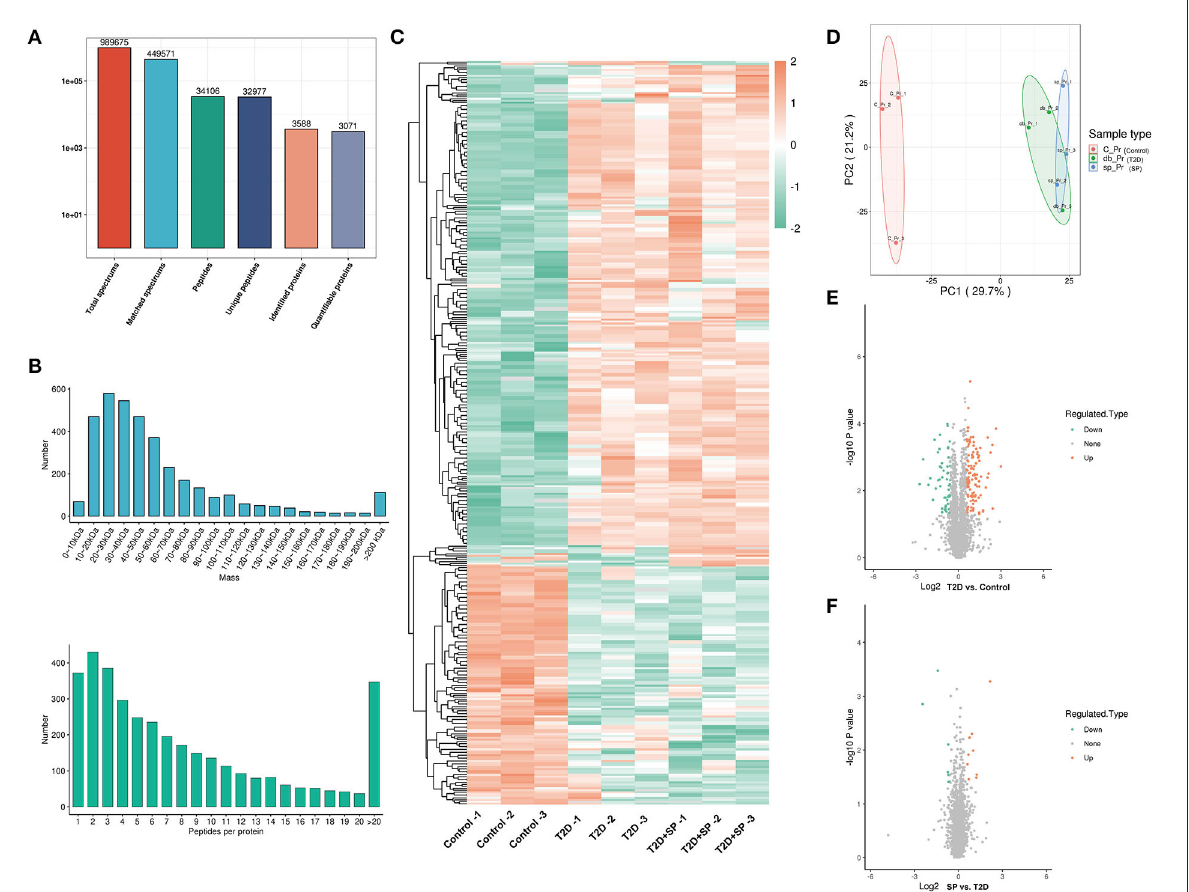
FIGURE3 Identification of differentially expressed proteins (DEPs) using mass spectrometry. (A) Bar graph summarizing the detected peptides and proteins, (B) distribution of detected peptides and proteins, (C) heatmap of DEPs in the heart tissues of the mice, (D) PCA of the proteomics data, the points represent different samples, (E) volcano plot showing the quantitative protein expression in cardiac tissues from C57BL/6 mice and db/db mice, DEPs with fold change > 1.5 are marked in color, and (F) volcano plot showing the quantitative protein expression of cardiac tissues between the T2D and T2D + SP groups, DEPs with fold change > 1.5 are marked in